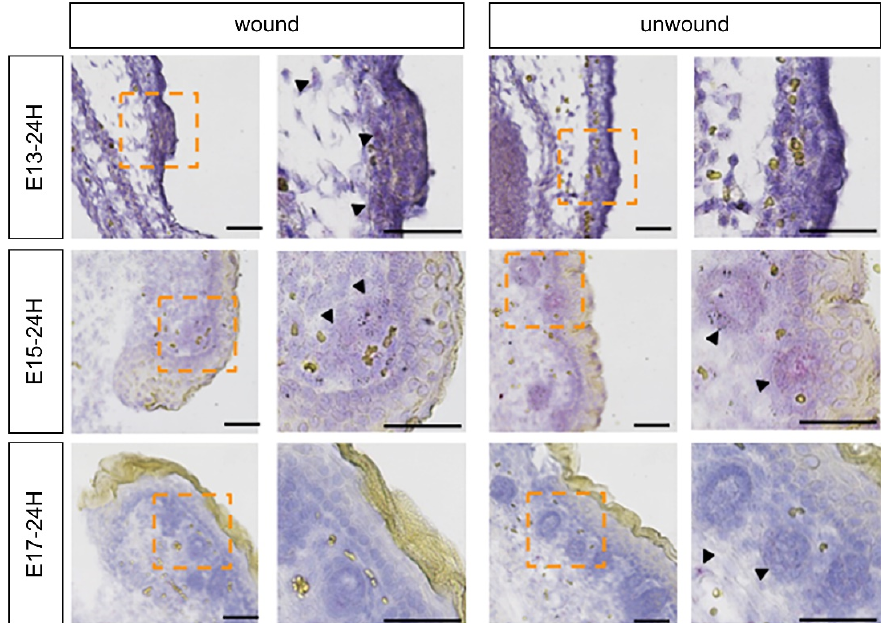
Figure 3. FGF7 expression during the wound healing process in mouse fetuses determined via in situ hybridization. FGF, fibroblast growth factor 7; E13, embryonic day 13. hybridization. FGF, fibroblast growth factor 7; E13, embryonic day